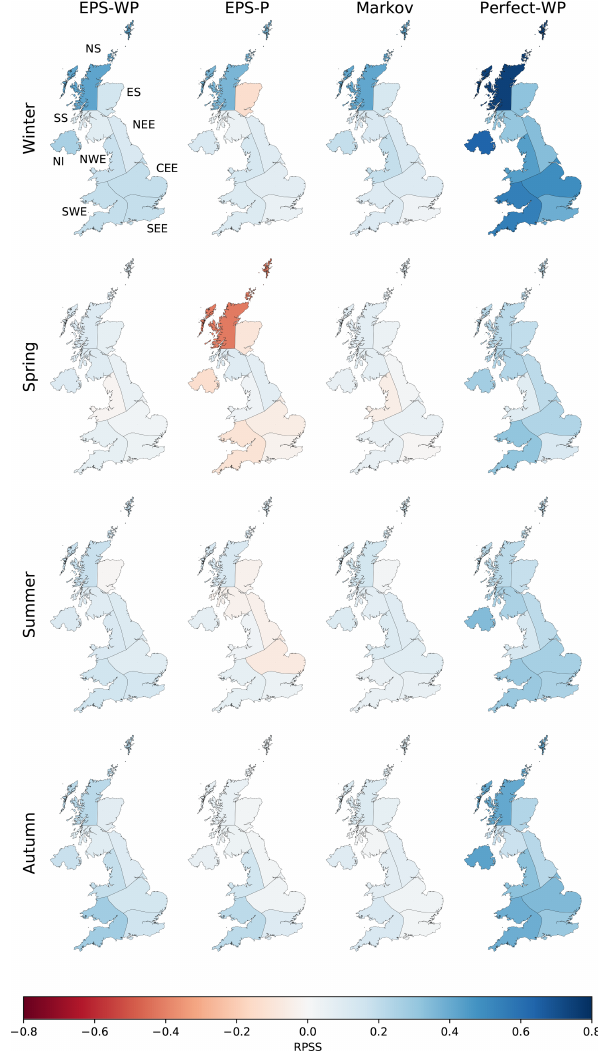
Figure 4. The ranked probability skill score (RPSS) for precipita- tion forecasts at a 16d lead for each model and season.